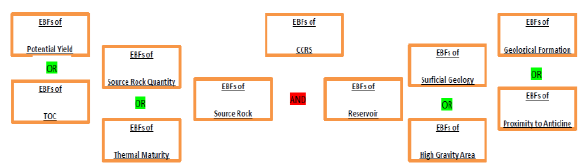
Figure 6. The proposed model for producing CCRS map with uncertainty measures in GIS